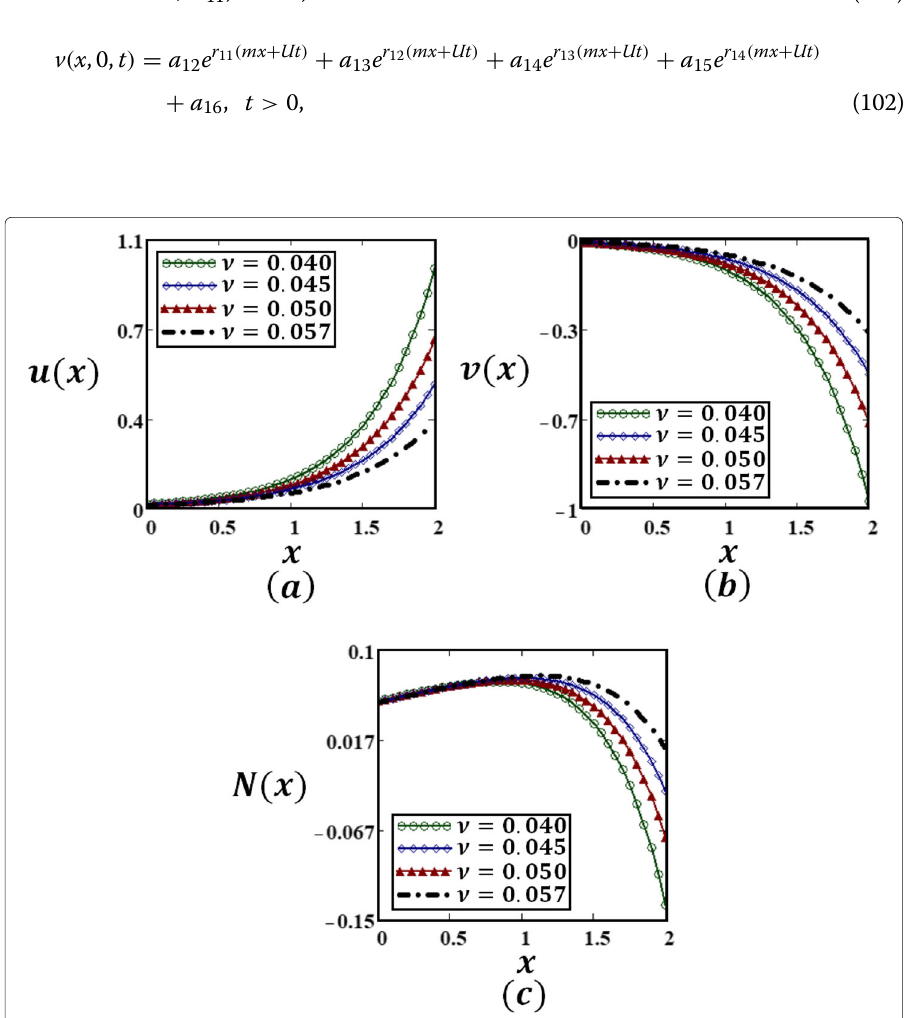
Fig. 6 Profiles of the velocity field u ( x , t ) , v ( x , t ) , and microrotation N ( x , t ) for MHD micropolar fluid given by Eqs. (32), (33), and (34), for U = 0.1, ρ = 12, κ = 0.2, B 0 = 2, k ∗ = 0.2, σ = 0.2, j = 0.03, m = n = 1, y = 1, c 0 = 0.01, t = 2 s , and different values of